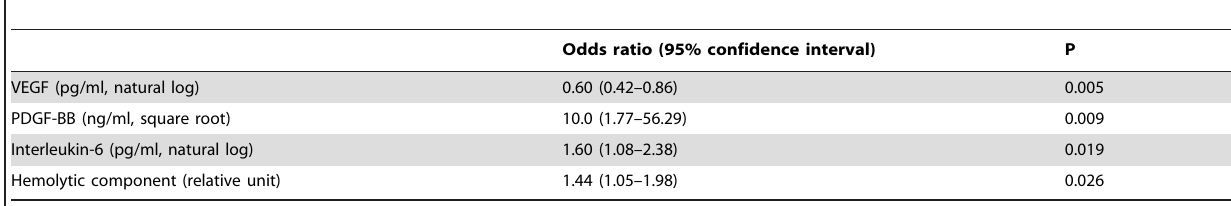
Table 4. Independent predictors of tricuspid regurgitation velocity $ 2.60 m/sec by logistic